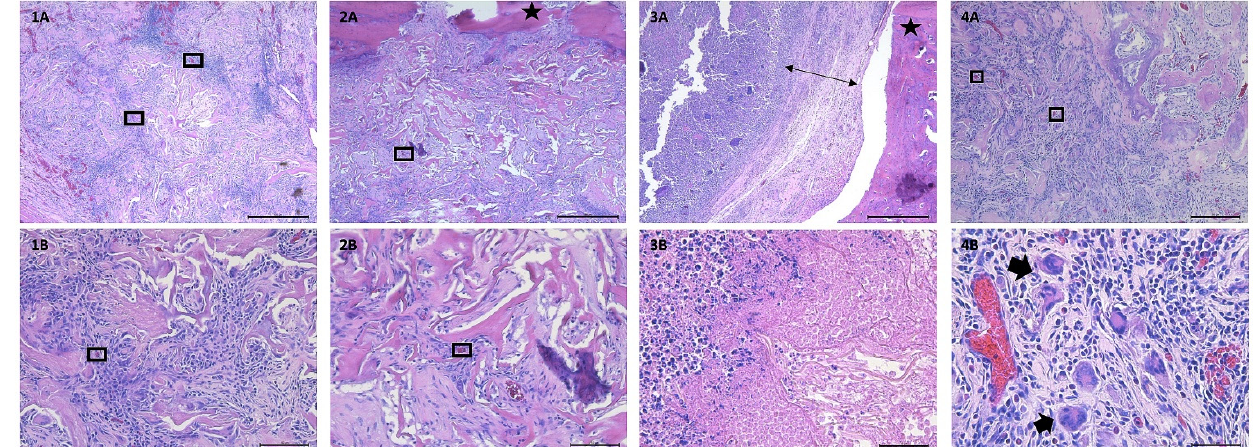
Figure 6. Histology images from control and experimental animals. ( 1A ) 5× magnification, demonstrating cellular and connective tissue infiltration into the native collagen matrix (control animal, rat #7). ( 1B ) 20× magnification, demonstrating cellular and connective tissue infiltration into native collagen matrix (control animal, rat #7). ( 2A ) 5× magnification, demonstrating cellular and connective tissue infiltration into antibiotic-loaded collagen matrix (experimental animal, rat #4). ( 2B ) 20× magnification, demonstrating cellular and connective tissue infiltration into antibiotic-loaded collagen matrix (experimental animal, rat #4). ( 3A ) 5× magnification, demonstrating thick ring of fibrous tissue separating bone from native collagen matrix and surrounding suppurative inflammation (control animal, rat #9). ( 3B ) 40× magnification, demonstrating dense population of neutrophils (left side of image), and necrotic cellular infiltration into native collagen matrix (control animal, rat #9). ( 4A ) 10× magnification, demonstrating cellular and connective tissue infiltration into antibiotic-loaded collagen matrix (experimental animal, rat #12). ( 4B ) 40× magnification, demonstrating presence of multinucleated giant cells, as well as blood vessels, throughout antibiotic-loaded collagen matrix (experimental animal, rat #12). Boxes are surrounding select blood vessels to highlight angiogenesis throughout the collagen matrix. Stars denote bone. Double-sided arrow highlights the thick rim of fibrous connective tissue. Thick arrows point at select multi-nucleated giant cells.